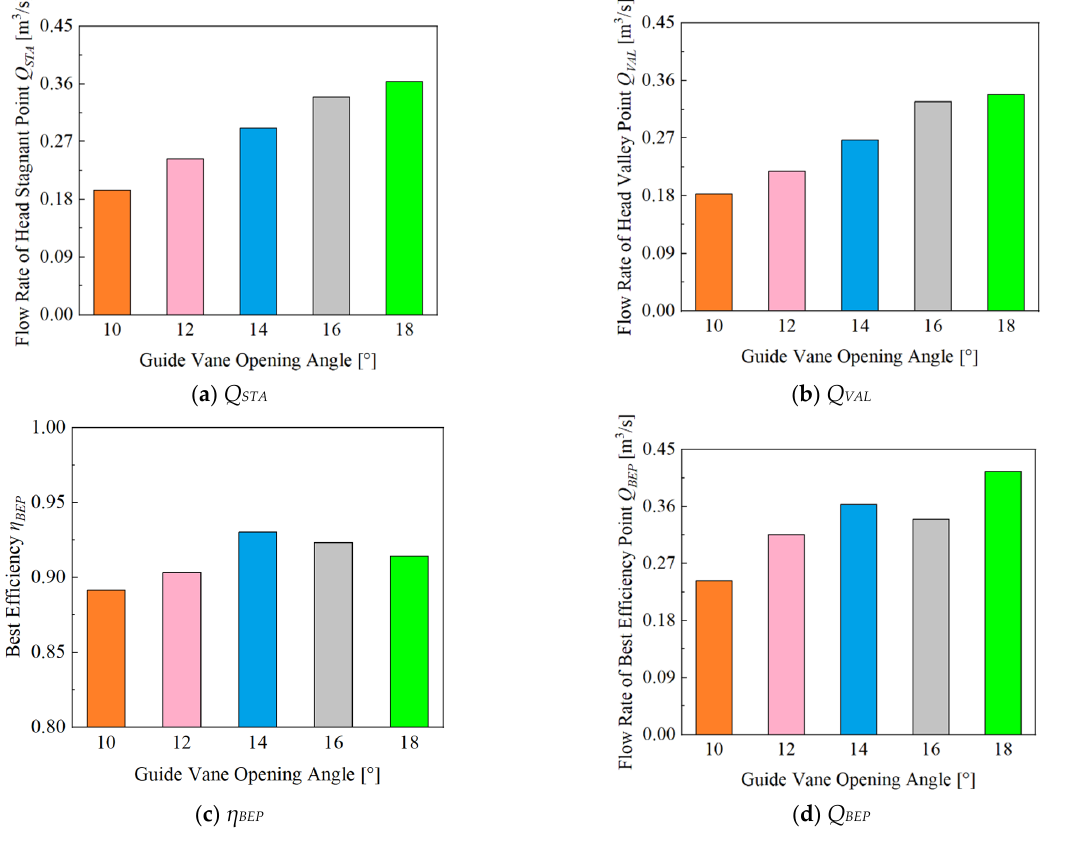
Figure 5. Variation in typical conditions of different attack angles α . ( a ) Q STA . ( b ) Q VAL . ( c ) η BEP . ( d ) Q BEP . ( d ) Q BEP